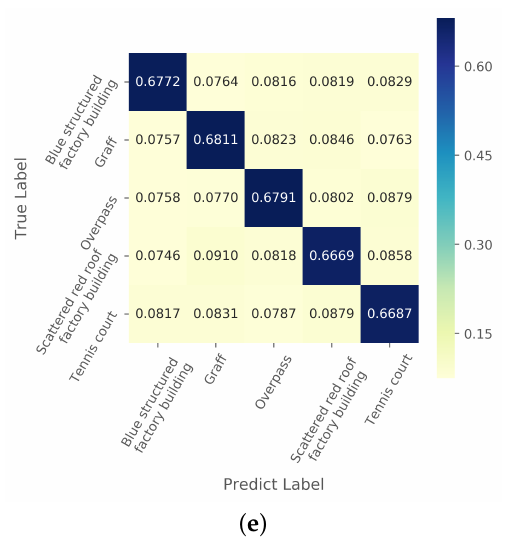
Figure 12. Confusion matrix of AMN results on 600 randomly selected tasks on the RSD46-WHU dataset. ( a – e ) confusion matrix of text results on experiment 1–5.